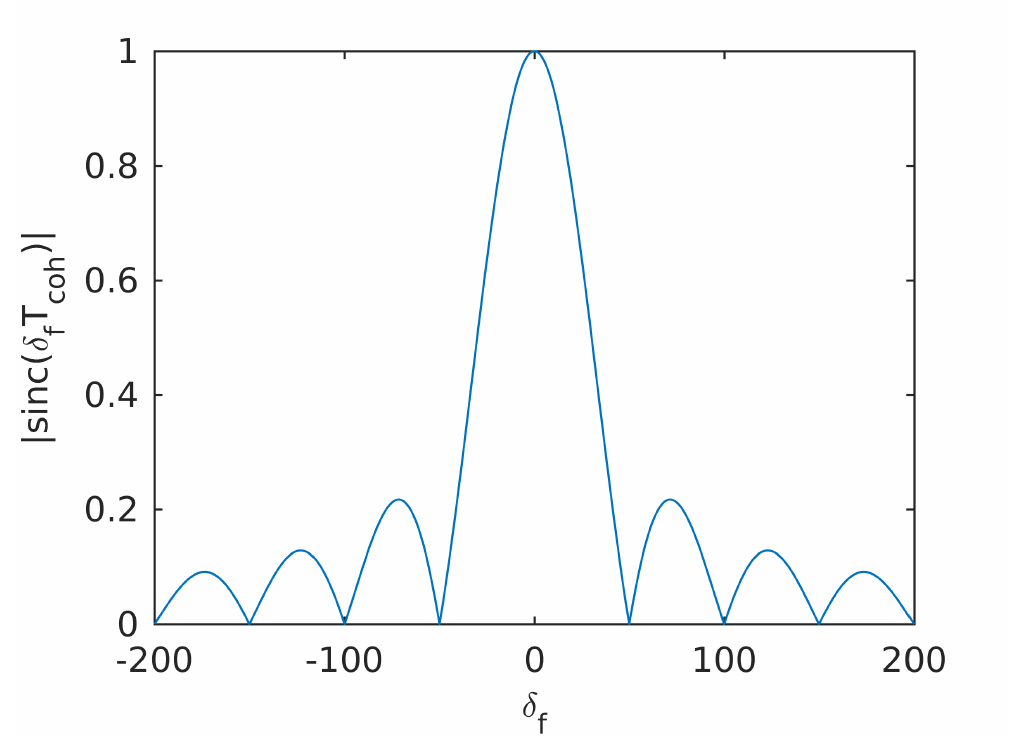
Figure 3. Signal amplitude with respect to Doppler error (with 20 ms of coherent